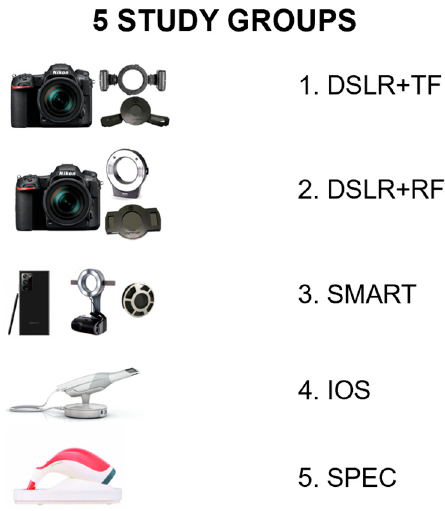
Figure 2. Study groups (shade selection methods) in this study.